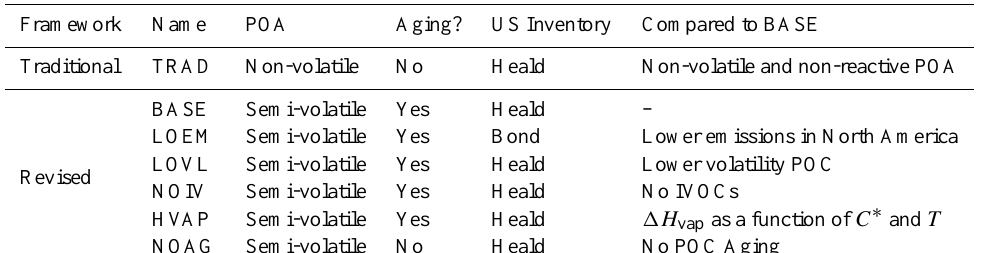
Table 3. Overview of simulations.